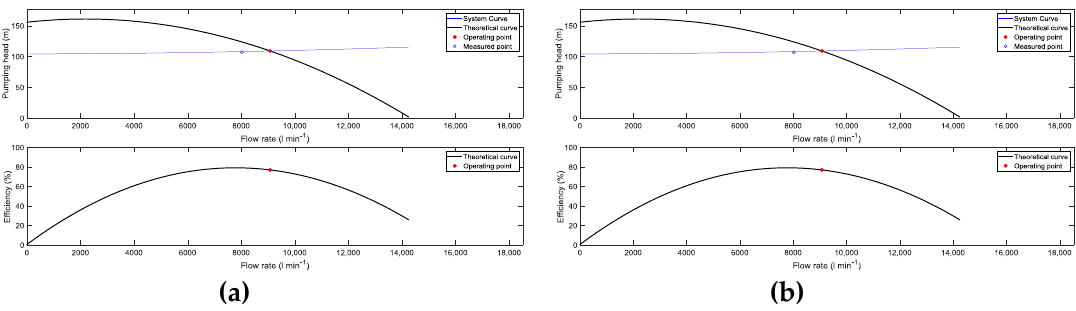
Figure 15. Operating point at fixed speed in WUA C for Case 2 in 2007 ( a ) and 2013 ( b ) irrigation seasons.